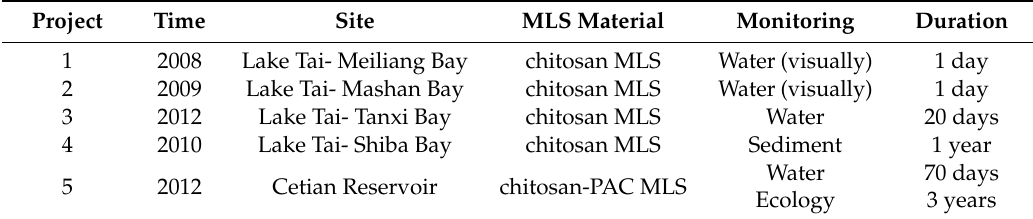
Table 1. The five engineering